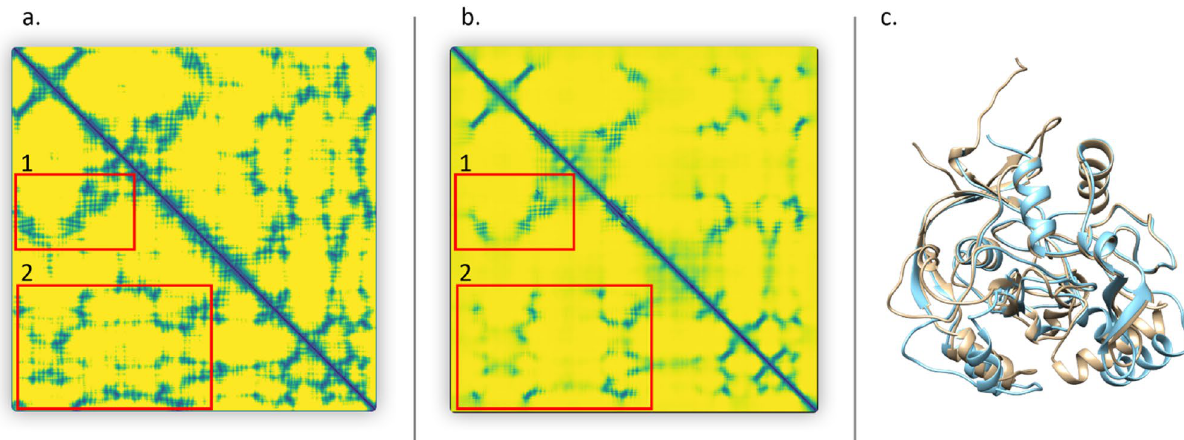
Figure 6. A good EMA example (T1028). ( A ) true distance map (darker collar means shorter distances). ( B ) predicted distance map. ( C ) top model selected by a MULTICOM predictor (MULTICOM-AI) (light blue) versus true structure (light yellow), both protein structures were visualized by Chimera 50 (version 1.15, https:// www. cgl. ucsf. edu/ chime ra/). The GDT-TS ranking loss is 0. Red rectangles in the maps highlight some long- range